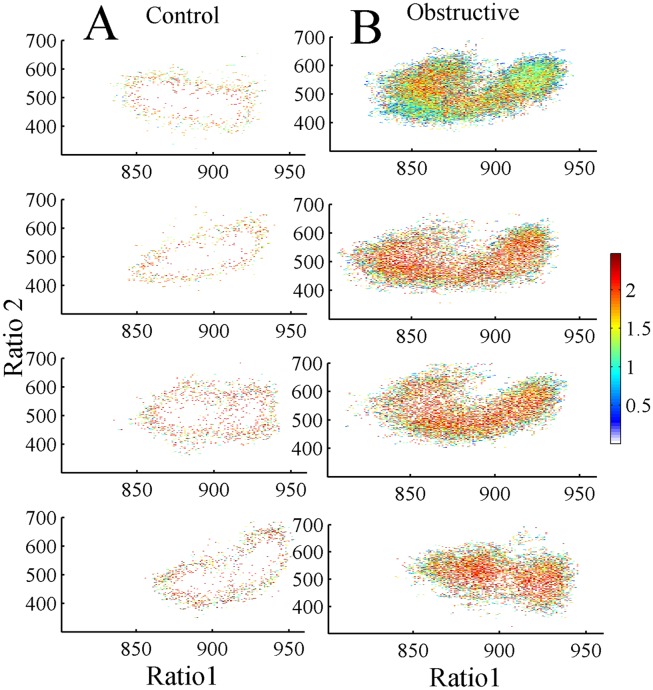
UAO group has faster movements in all regions of the 2D state space plot compared to controls.Plots represent four different control (A) and UAO (B) animals. The velocity of spectral change was calculated as the distance between two consecutive data points and so temporal resolution was second-by-second. Values represent average velocities originating at that site. Warm colors show faster velocity (transition regions) indicating unstable states, and cool colors low velocities at stable states. UAO animals have faster movements.